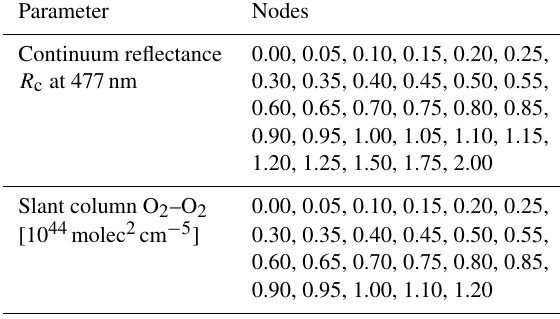
Table 2. Nodes for the continuum reflectance and the slant column O 2 –O 2 , for the cloud fraction/pressure and scene albedo/scene pres- sure look-up tables. The solar zenith angle, viewing zenith angle, relative azimuth angle, surface albedo and surface/cloud pressure nodes are the same as given in Table 1.